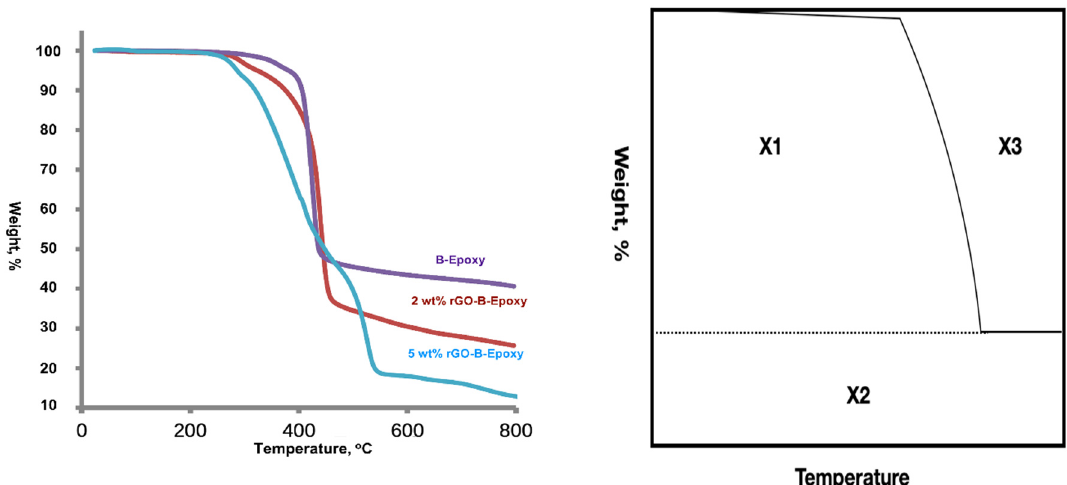
Figure 8. TGA results for epoxy-based composite coatings ( left ) and IDPT method by Doyle ( right ).